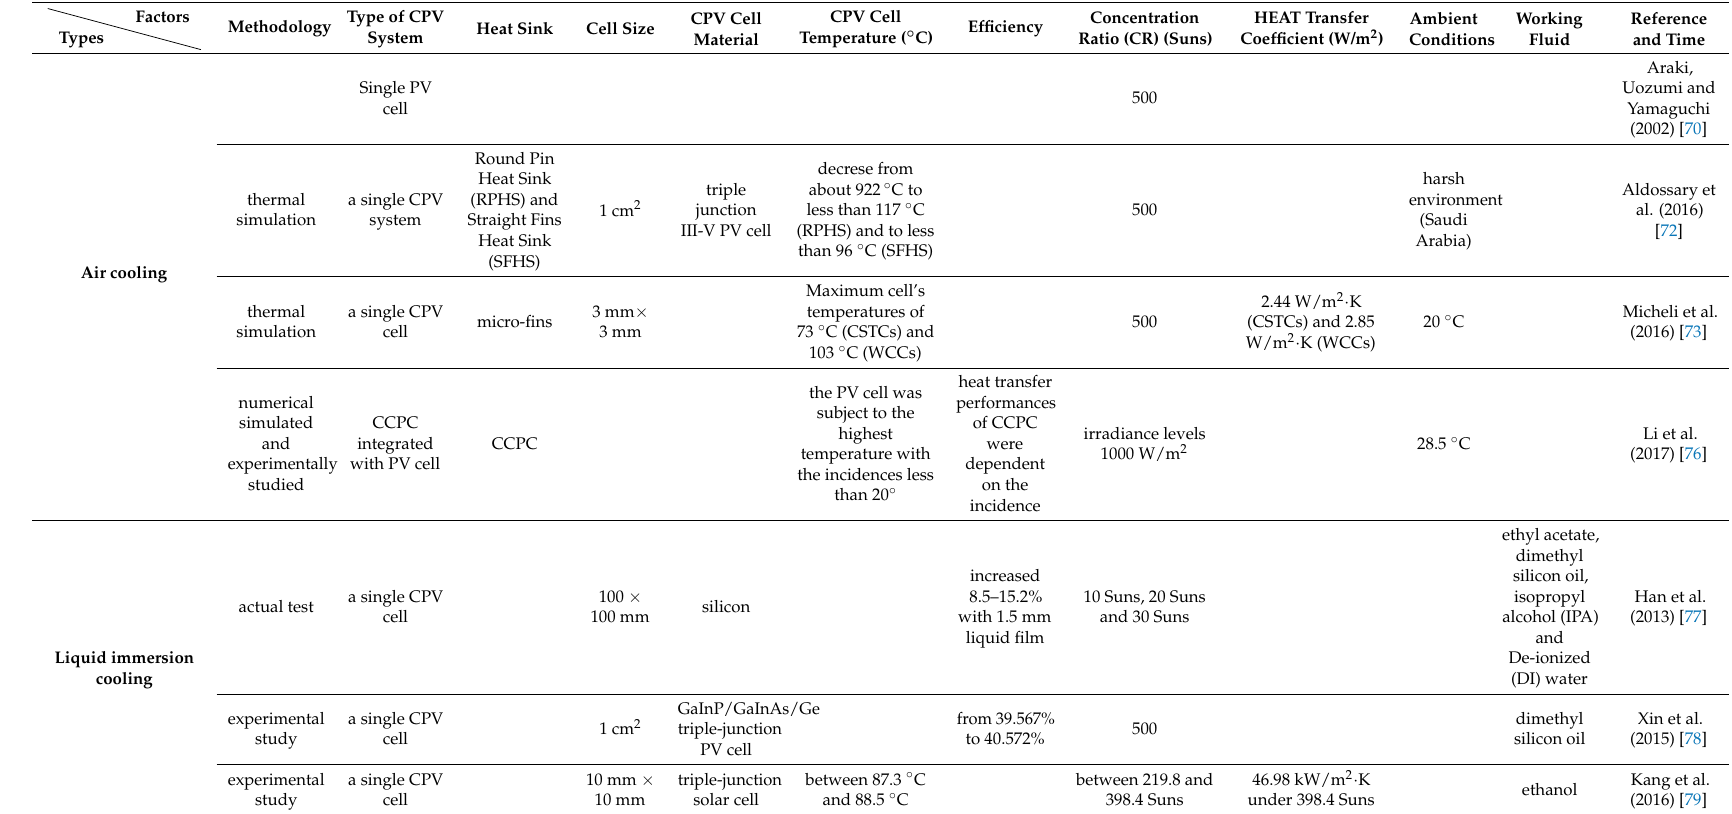
Table 4. Summary of the Passive Cooling